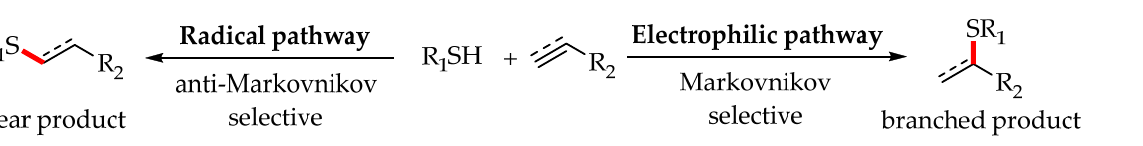
Figure 1. Selected pharmaceuticals bearing thioether moiety.